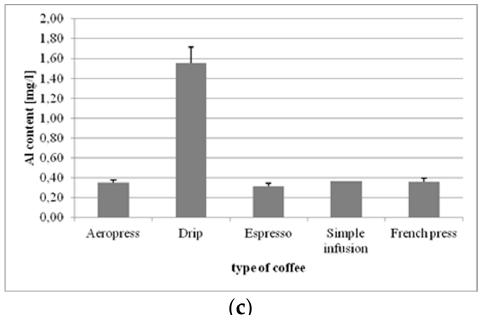
Figure 4. Concentrations of Ni ( a ), Sr ( b ), and Al ( c ) in coffee beverages made using different methods.